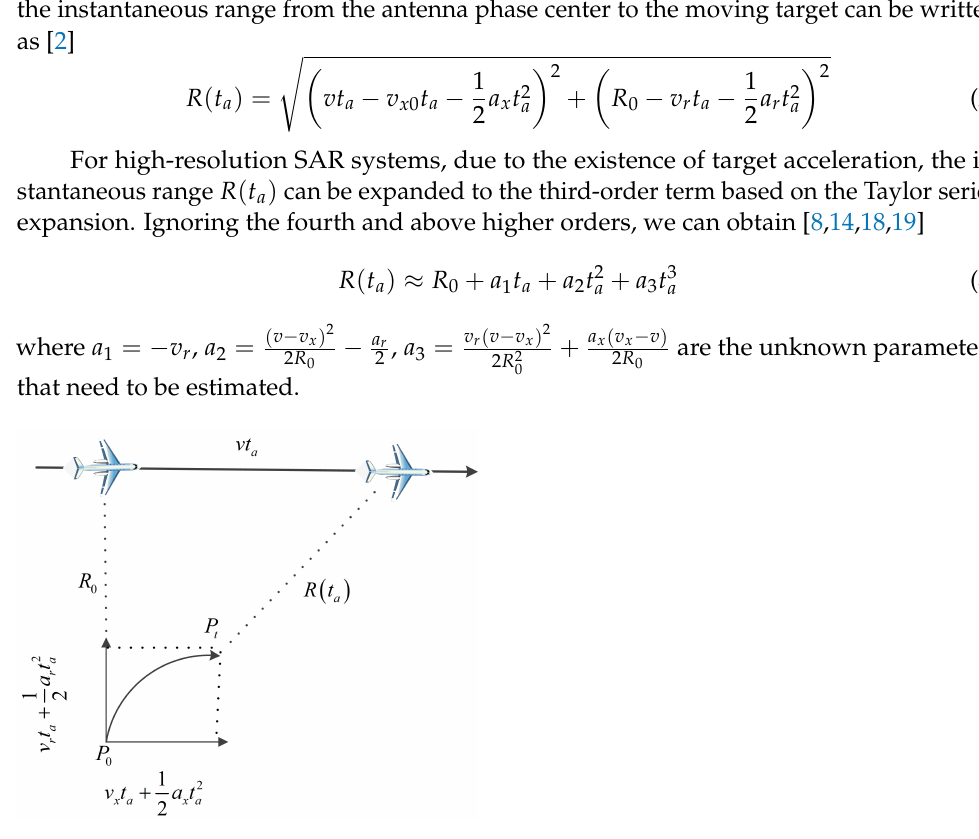
Figure 1. The observation geometry between airborne SAR platform and a moving